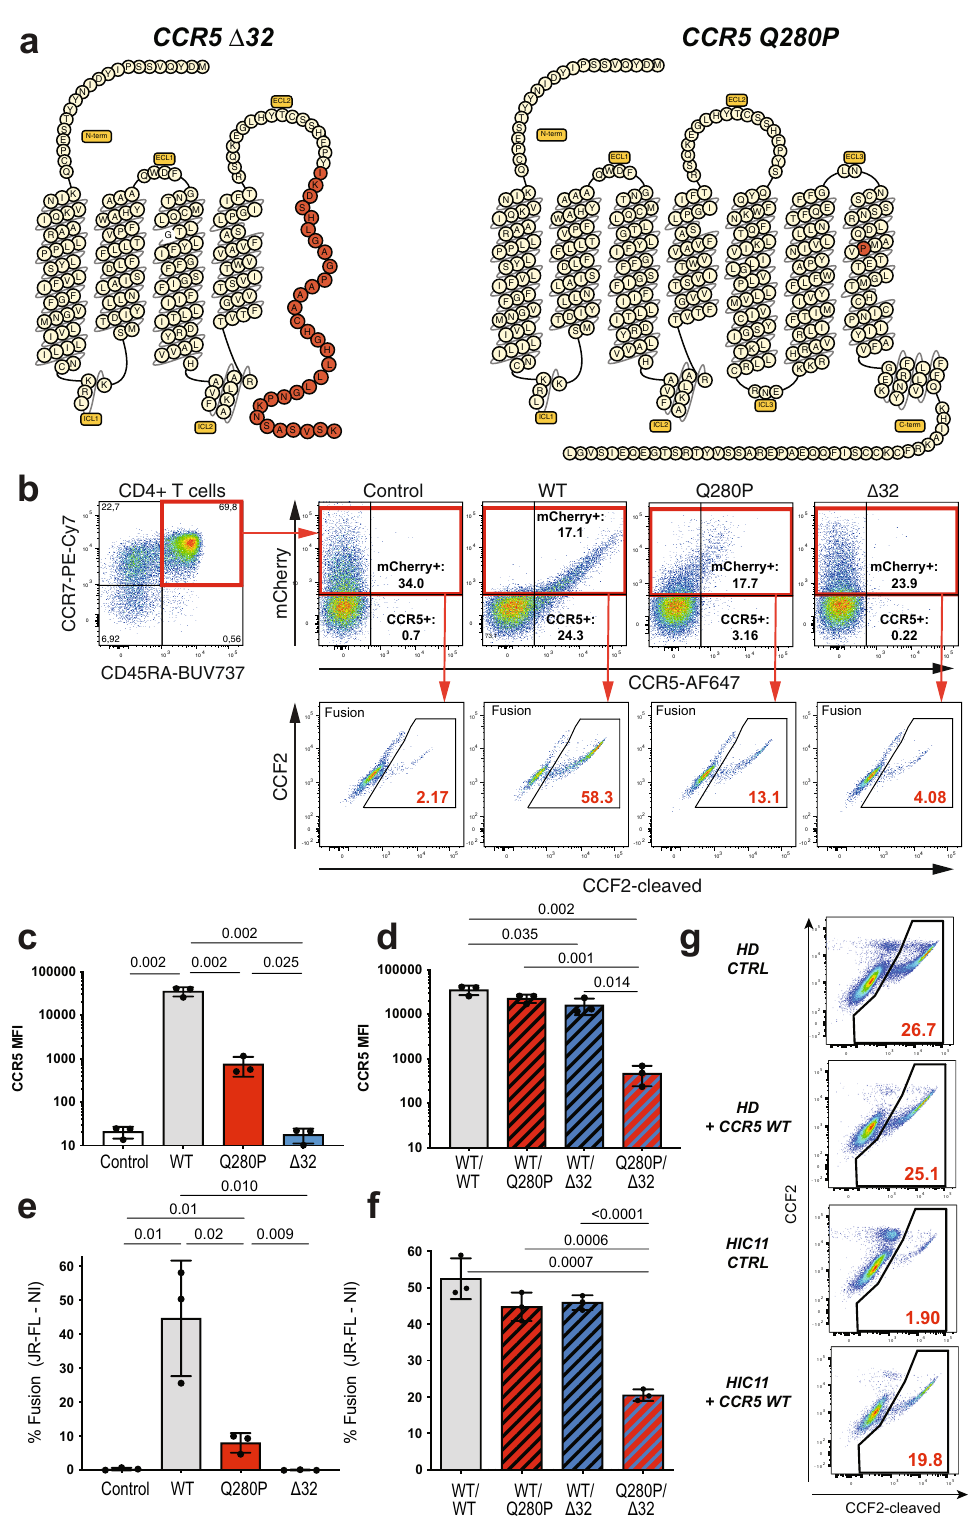
Fig. 6 Biallelic mutations limit CCR5 surface expression in controller patient HIC11. a Schematic representation of CCR5 mutations Δ 32 and Q280P found in patient HIC11. Modi fi ed amino acids are represented in red. ECL Extracellular loop. ICL Intracellular loop. b – f Effect of CCR5 mutations in primary CD4 + T cells: CCR5-T2A-mCherry wild-type (WT) or mutant plasmids were nucleofected in PBMC, and CCR5 expression was measured in the naive CD45RA + CCR7 + population. b Gating strategy for the combined analysis of CCR5 expression and HIV-1 JR-FL fusion. Nucleofection is measured by the % mCherry + cells in naive CD4 + T cells. Fusion is measured by the % CCF2-cleaved + cells in mCherry + naive cells. c , d Quanti fi cation of CCR5 expression and ( e , f ) of HIV-1 JR-FL fusion, after single nucleofection ( c , e ) or co-nucleofection ( d , f ) of CCR5 plasmids. Means ± SD for n = 3 experiments are reported, with P values computed by Student ’ s t-test. g HIV-1 JR-FL fusion (red) is analyzed in total CD4 + T cells of one HD and of patient HIC11, either untreated (CTRL) or nucleoporated with CCR5 WT plasmid ( n = 1